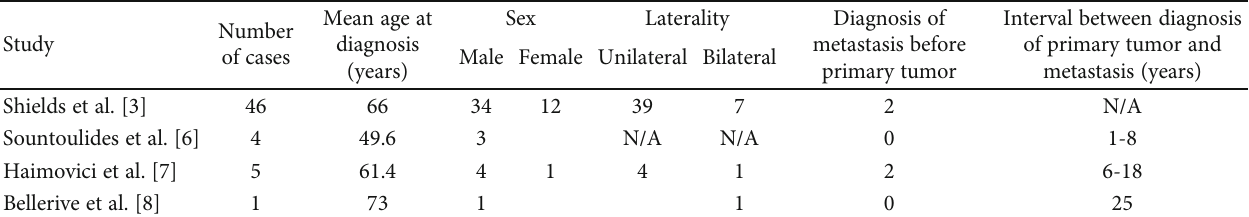
Table 1: Cases of renal cell carcinoma with metastases to the choroid. In nine cases, the choroidal metastases were bilateral.